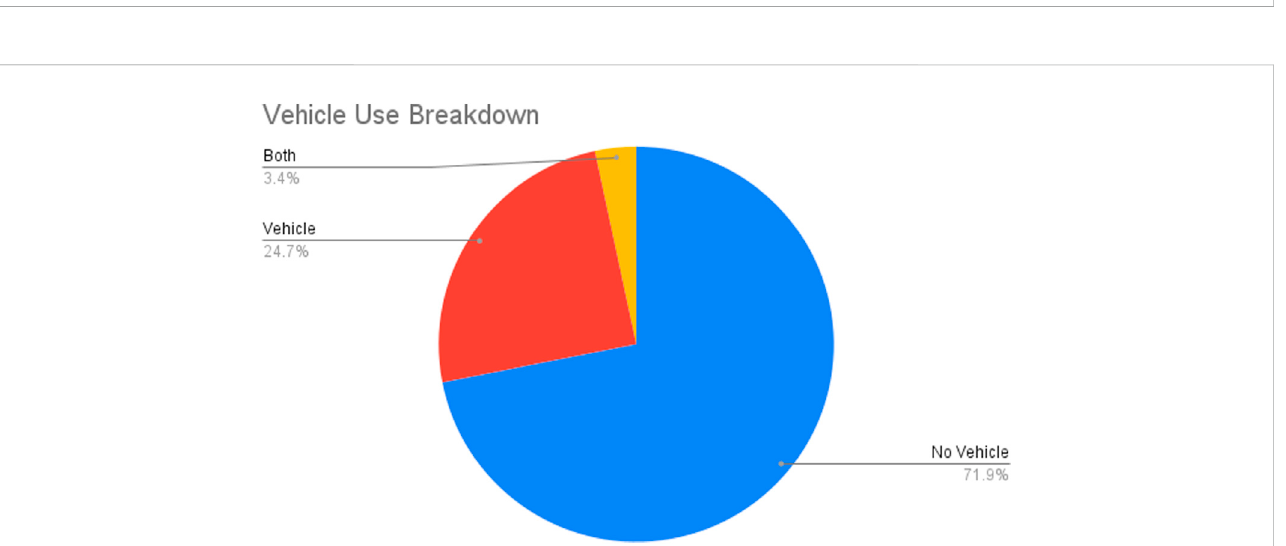
The number of papers featuring each level of